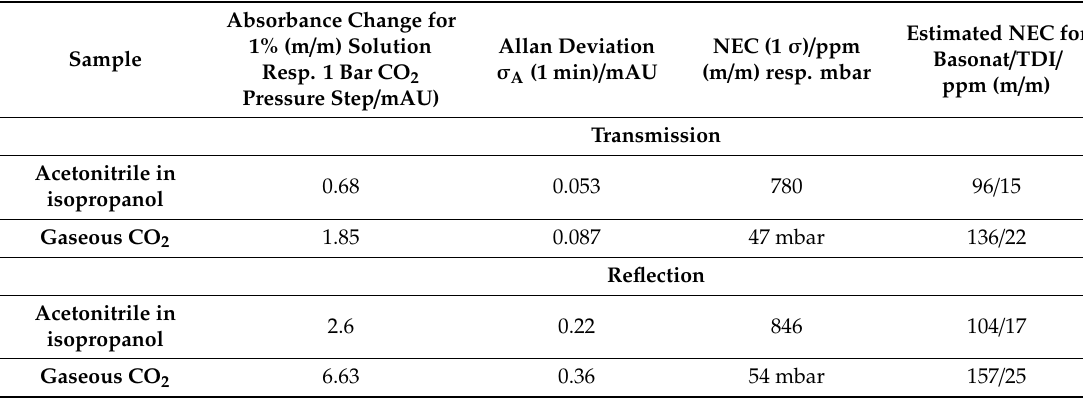
Table 3. Analysis of the ATR experiments with sapphire tubes. NEC (1 σ)-values for Basonat respectively TDI are estimated using the conversion factors from Table 2.